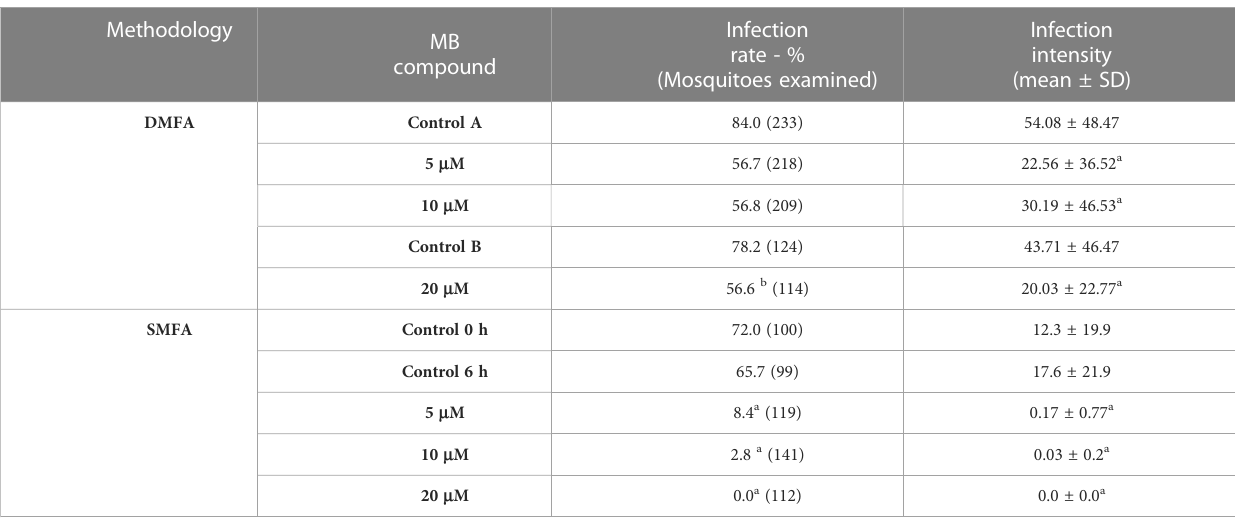
TABLE 2 Infection and intensity rates of DMFA and SMFA